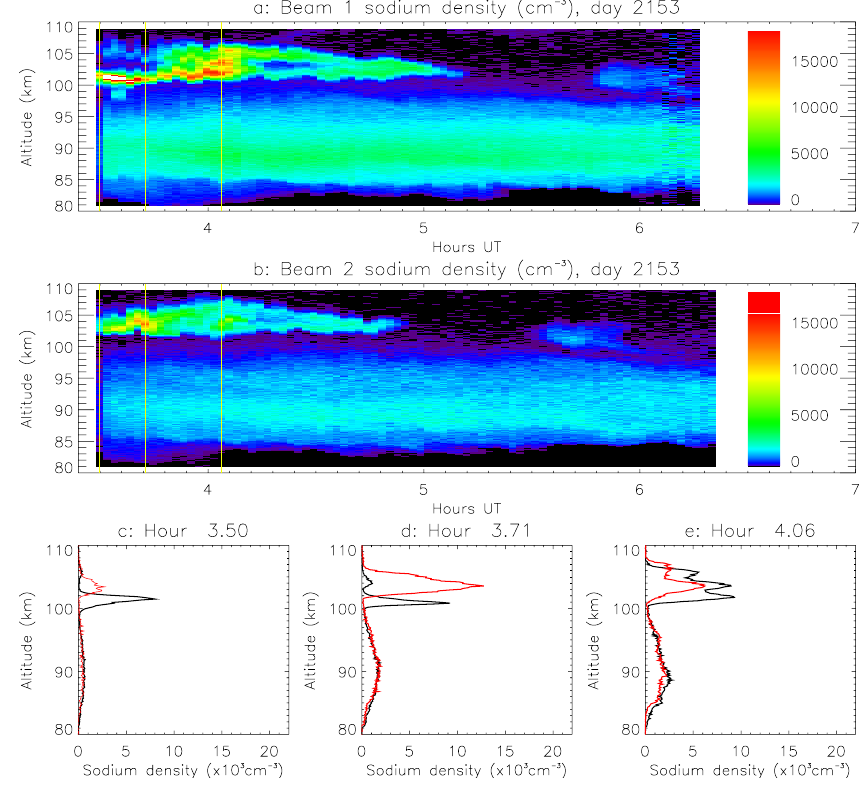
Fig. 1. Sodium density contours for both beams and altitude profiles at three times (marked by yellow lines) for beam 1 (black) and beam 2